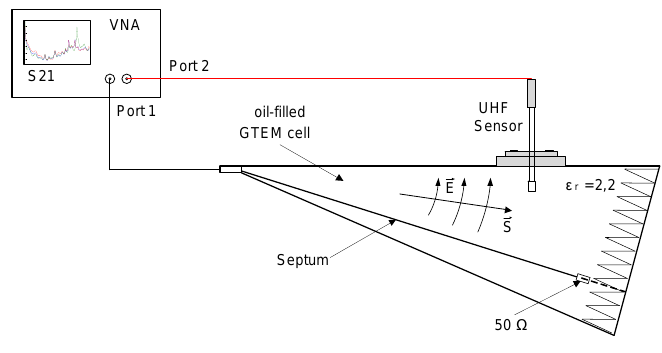
Figure 3. Transmission measurement ( S 21 ) for antenna factor (AF) determination [13].